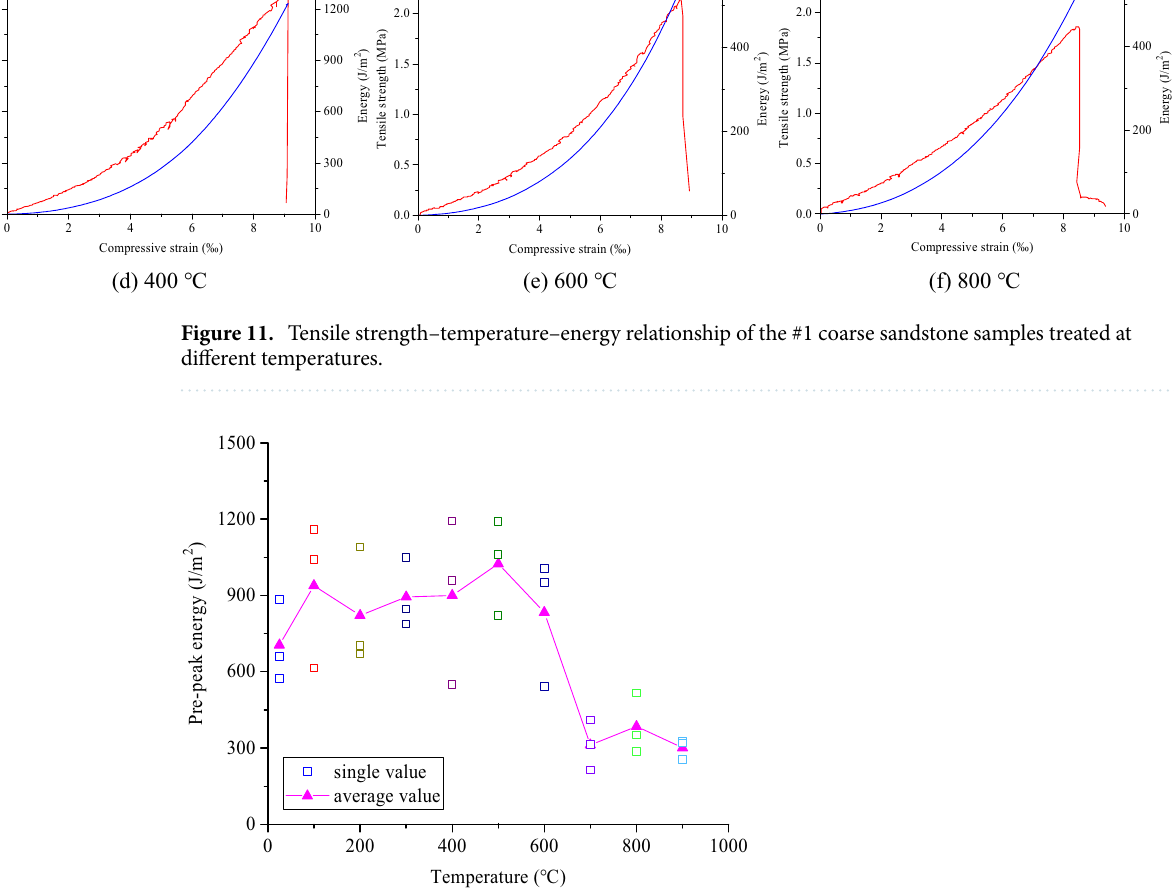
Figure 12. Relationship between the peak energy of the samples and the treatment